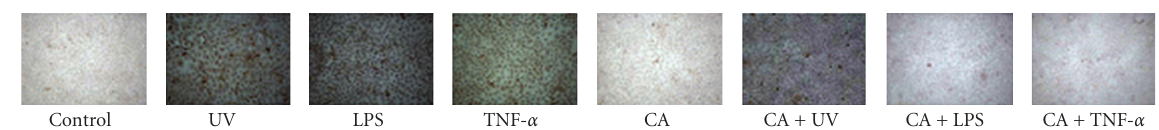
Figure 6: Immunostaining of LL-37 was more intense in the LPS, TNF- α treated, and UV irradiated groups than in the normal control. In the additional groups treated with calcipotriol, immunostaining for LL-37 was less intense than for the stimulant groups.